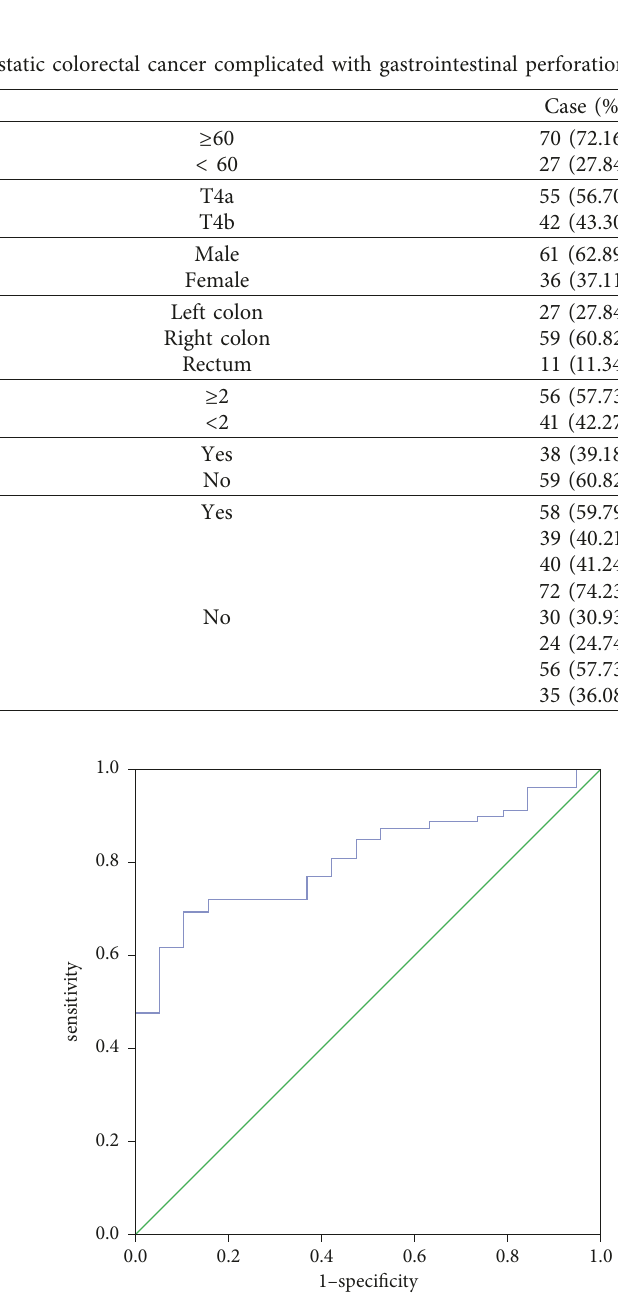
Figure 2: The evaluation value of ctDNA expression in